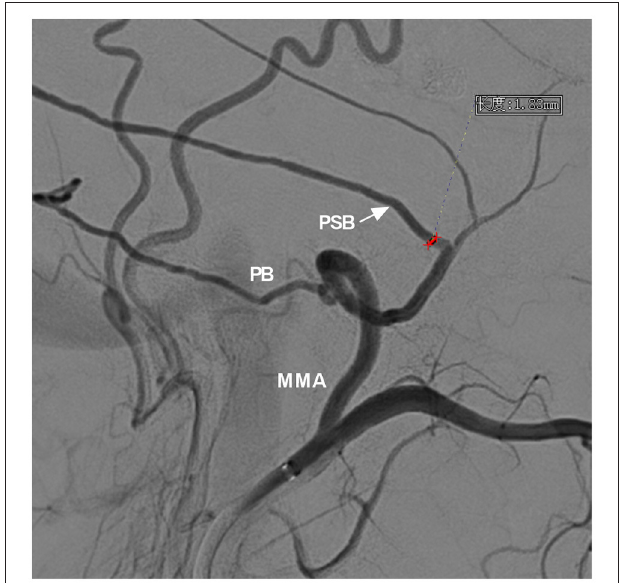
FIGURE 4 | Measurement of the diameter of the MMA branch origin from the trunk. DSA showed the MMA and its branches. For the case of a DAVF with the PSB and PB acting as the main feeding arteries, the PSB (arrow) was chosen as the arterial path to perform EVT, and the diameter of the PSB origin from the trunk was measured (red line segment). DSA, digital subtraction angiography; EVT, endovascular treatment; MMA, middle meningeal artery; PB, petrous branch; PSB, petrosquamosal